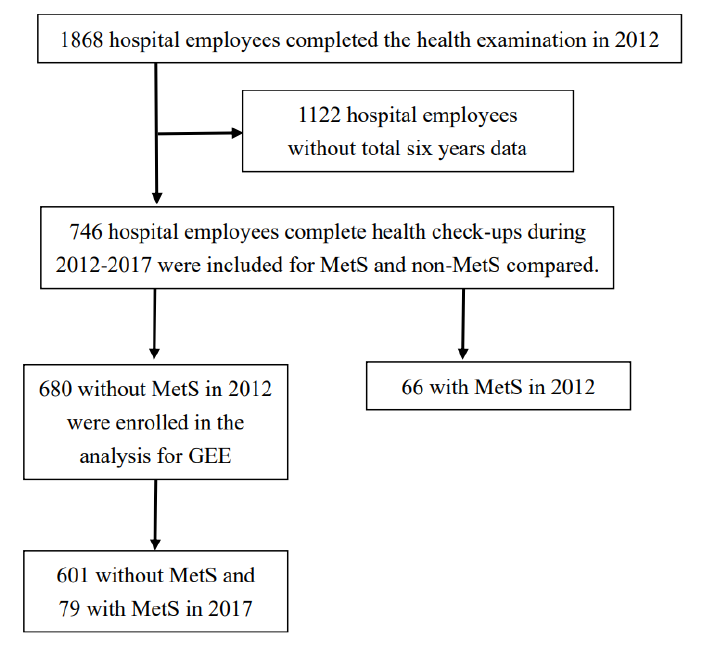
Figure 1. Flow chart of enrolment of study participants. MetS was diagnosed based on the NCEP-ATP III guidelines and modified